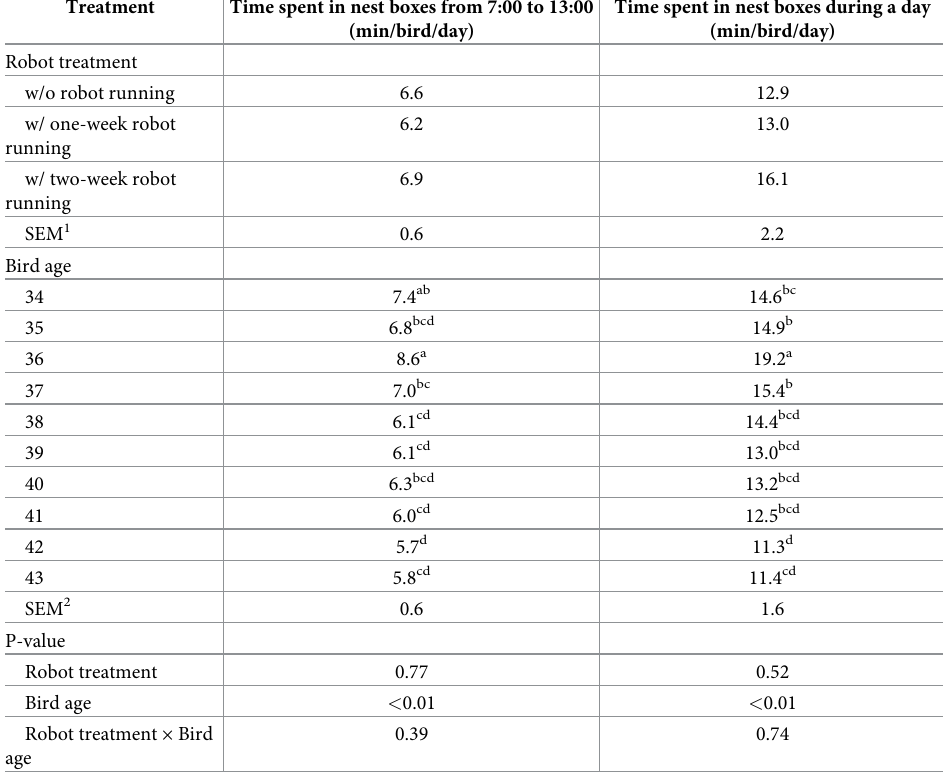
Note: a,b,c,d Values having different superscripts within the same treatment are significantly different, with a significance level of 0.05, least square difference post-hoc analysis, and PROC MIXED statement. 1 Standard errors are for the effect of robot treatment (n = 40) and 2 Standard errors are for the effect of bird age (n = 12). ‘w/’ and ‘w/ o’ represent with and without,